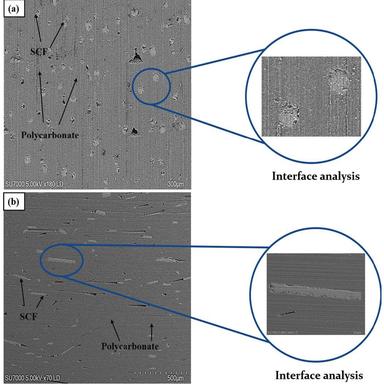
Uniform distribution of SCF inside the PC matrix material in two different directions.